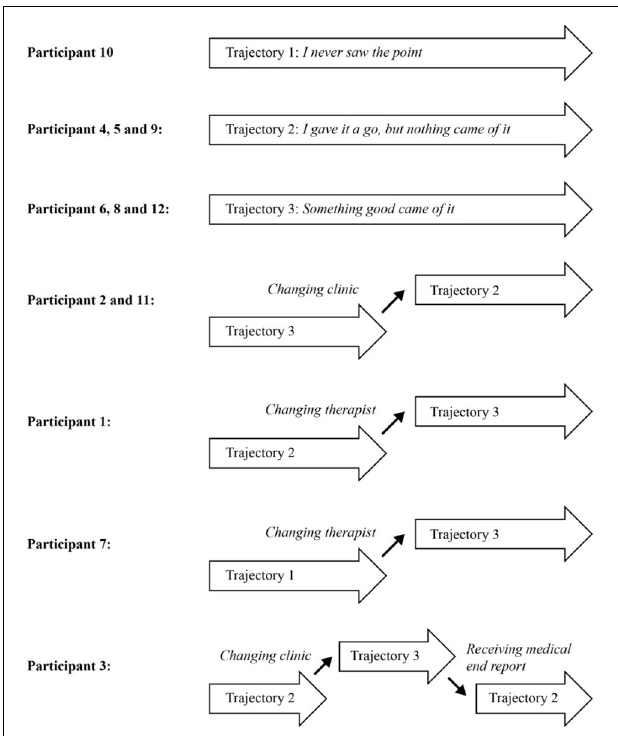
FIGURE 1 | Overview of the twelve participants’ trajectories through mental health care at others’